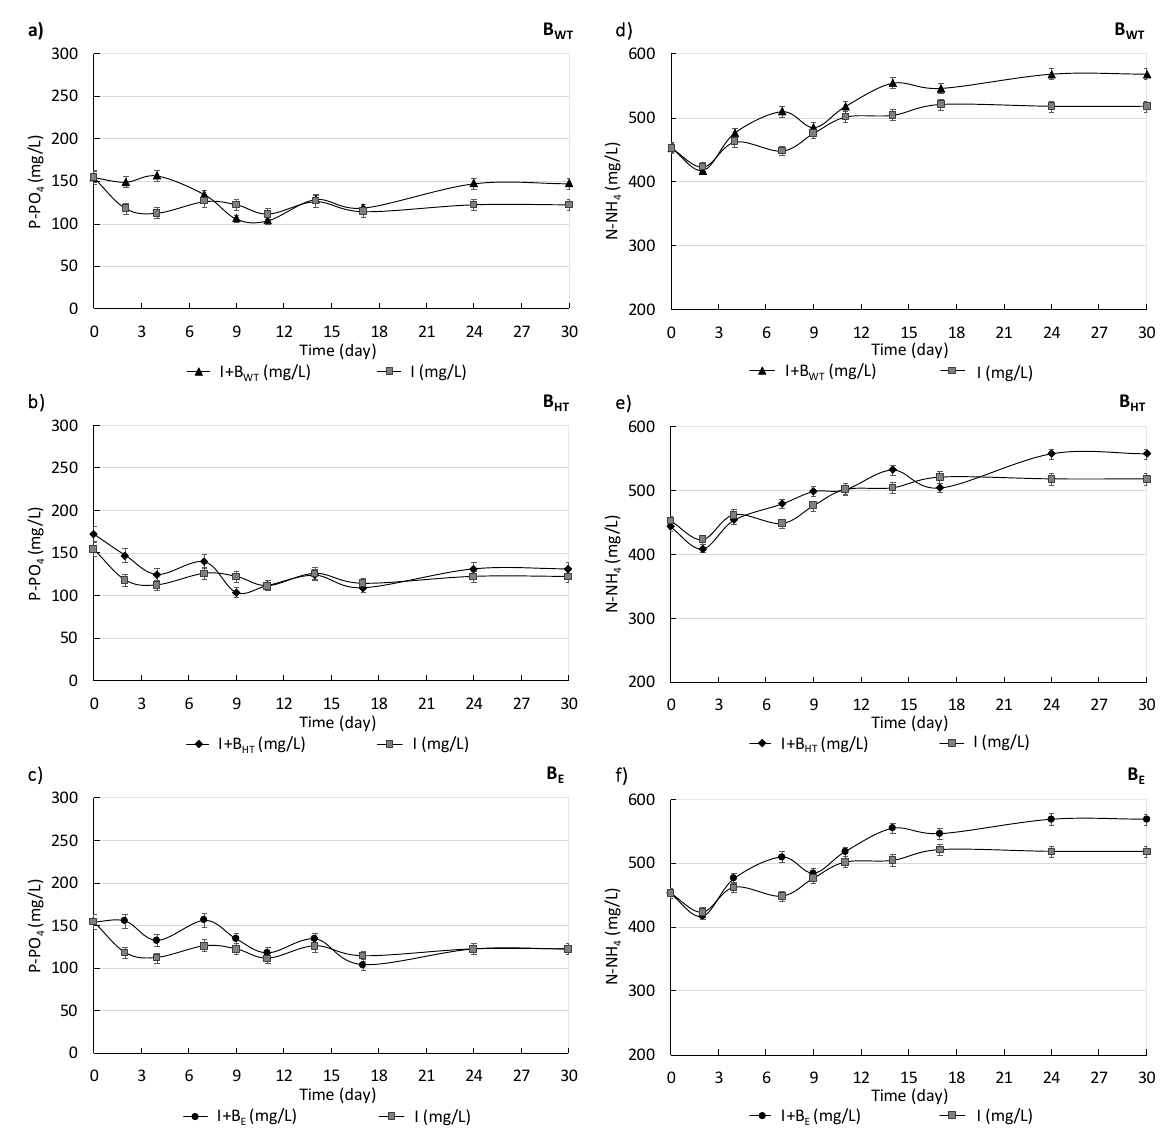
Figure 2. P ‐ PO 4 ( a – c ) and N ‐ NH 4 ( d – f ) concentrations in supernatants from I, I+B WT , I+B E, and I+B HT Figure 2. P-PO 4 ( a – c ) and N-NH 4 ( d – f ) concentrations in supernatants from I, I+B WT , I+B E, and during the measurements of methane production. I+B HT during the measurements of methane